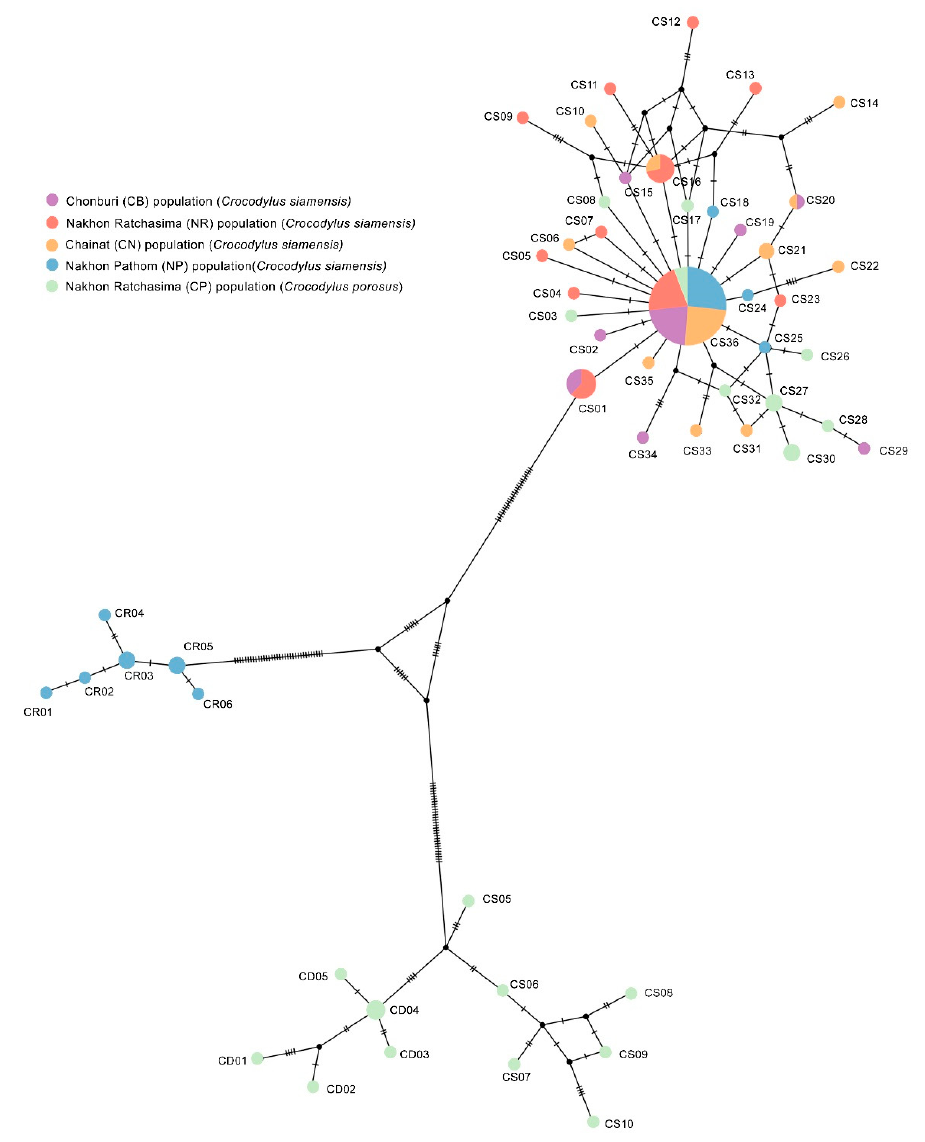
Figure 4. Haplotype network based on sequence data for the mitochondrial DNA D-loop region of Siamese ( Crocodylus siamensis , Schneider, 1801) [1] and saltwater crocodiles ( Crocodylus porosus, Schneider, 1801) [13]. Table 5. Mitochondrial DNA D-loop sequence diversity of Siamese ( Crocodylus siamensis , Schneider,